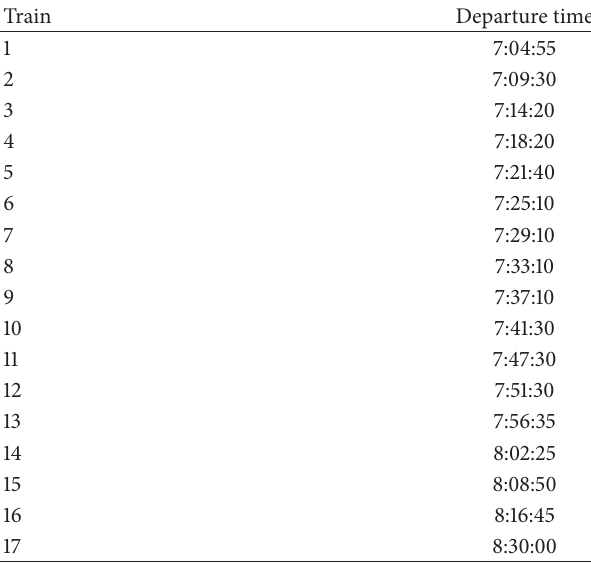
Table5:Bestsolution:departuretimesoftrainsatthestartterminal.